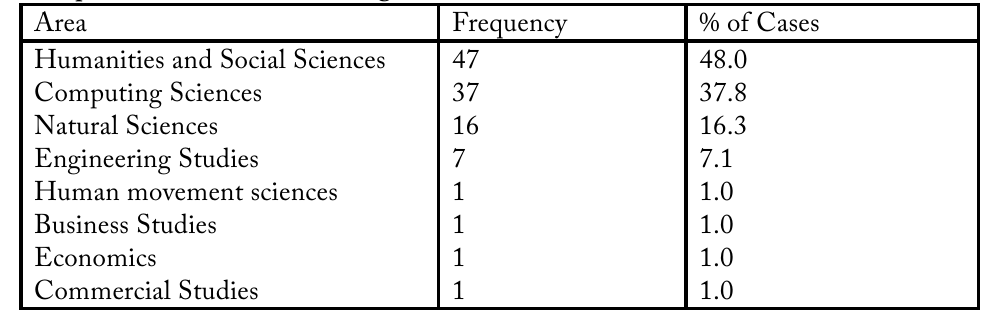
Table 4: Respondents’ educational background (N =